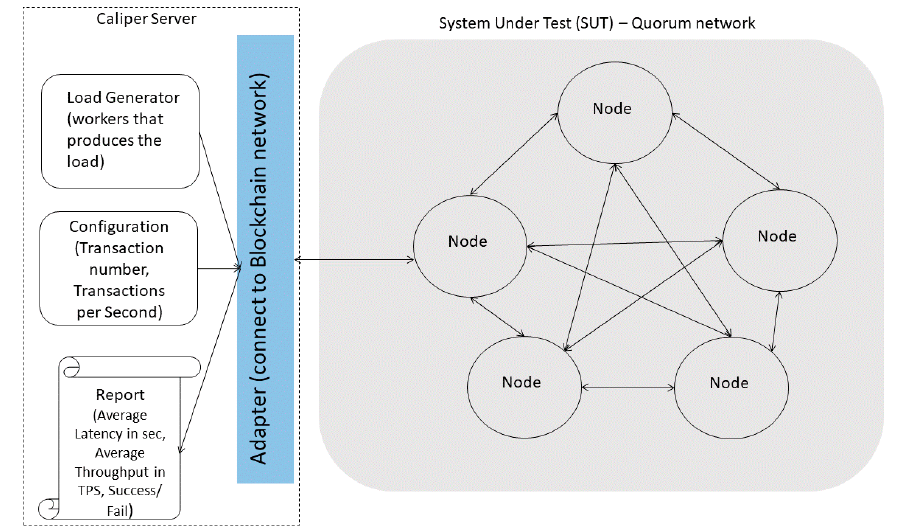
Figure 2. The experimental testbed .